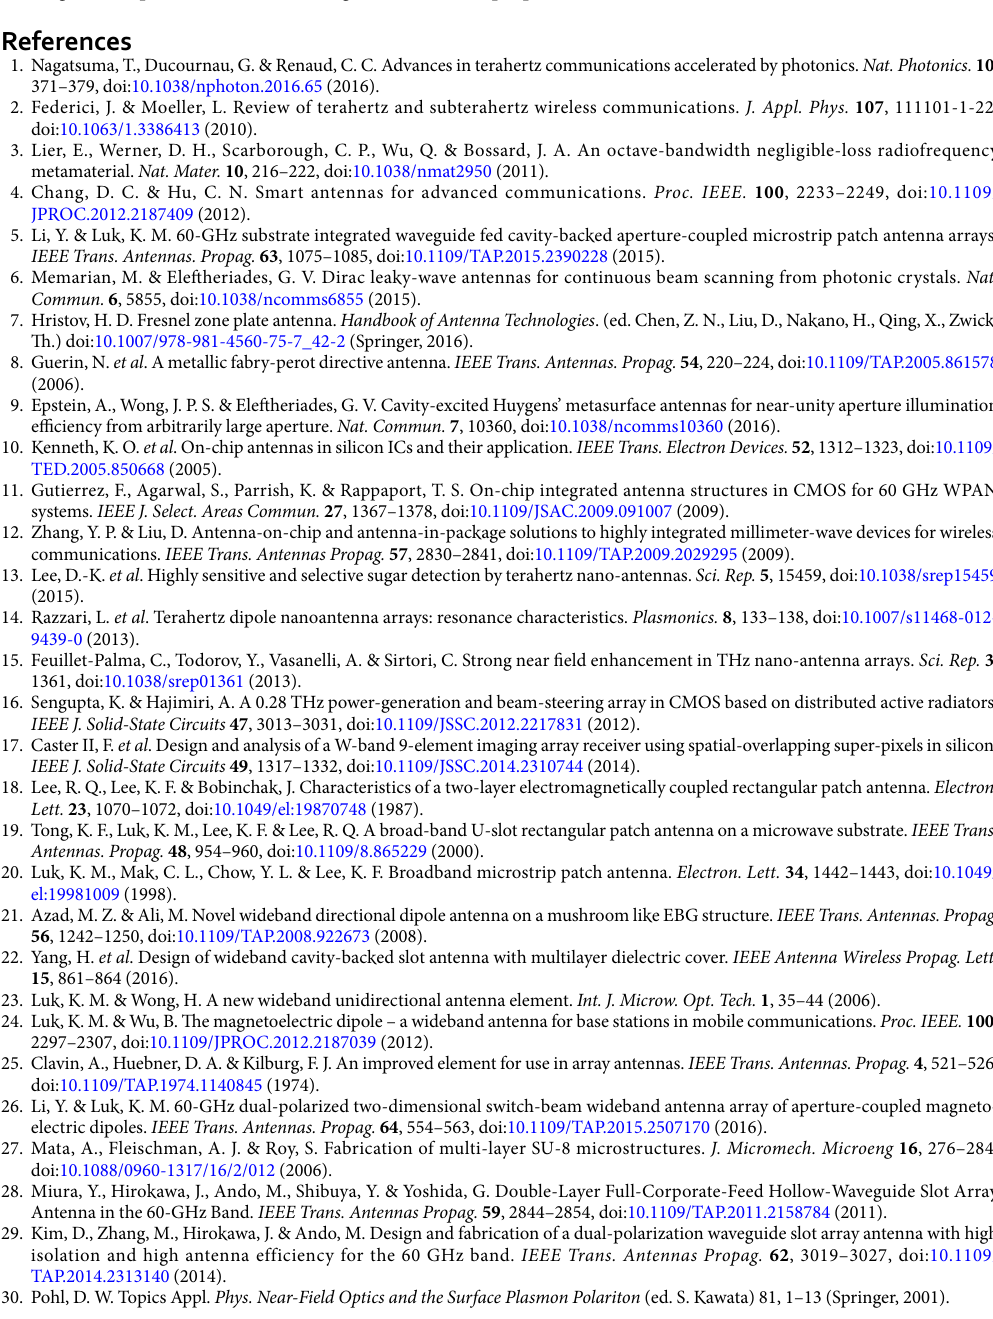
Fig. 12. The antenna under test (AUT) as the transmitting antenna with fixtures is mounted on the VDI module pointing toward the center of the rotation. The rotational stage is manually operated which can rotate in angular direction up to ± 90° horizontally with a precision of 1°. All the horizontal and vertical alignments are achieved by using a 2-axis laser tracker. A standard horn antenna with a nominal antenna gain of 22 dBi at the frequency range of 0.75–1.1 THz is used for the receive antenna at a far-field distance of 159 mm (159 λ o in separation at 1.0 THz). The receive horn antenna is connected to the WR01.0 VDI network analyzer extension module for receiving the RF power from the AUT. RF absorbers are used around the platform. For the gain measurement, two identical standard gain horns from VDI, WR 01.0 Diagonal Horn, with frequency range of 0.75 to 1.1 THz, are employed for making the direct gain comparison to retrieve the gain value of the proposed